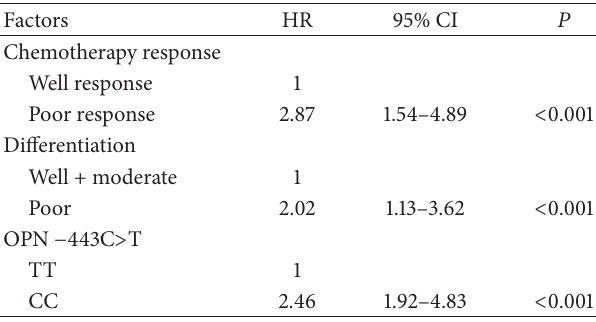
Table 4: HR for prognosis of NSCLC patients that underwent